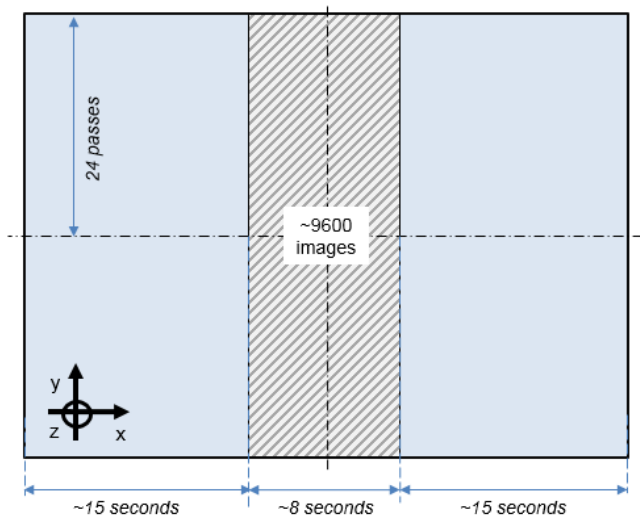
Figure 9. Schematic representation of a workpiece layer with the approximate duration of a tool pass (in seconds) and the total number of tool passes per layer. The shade depicts the area where the force values are chosen for validating of the CNN model in real time.